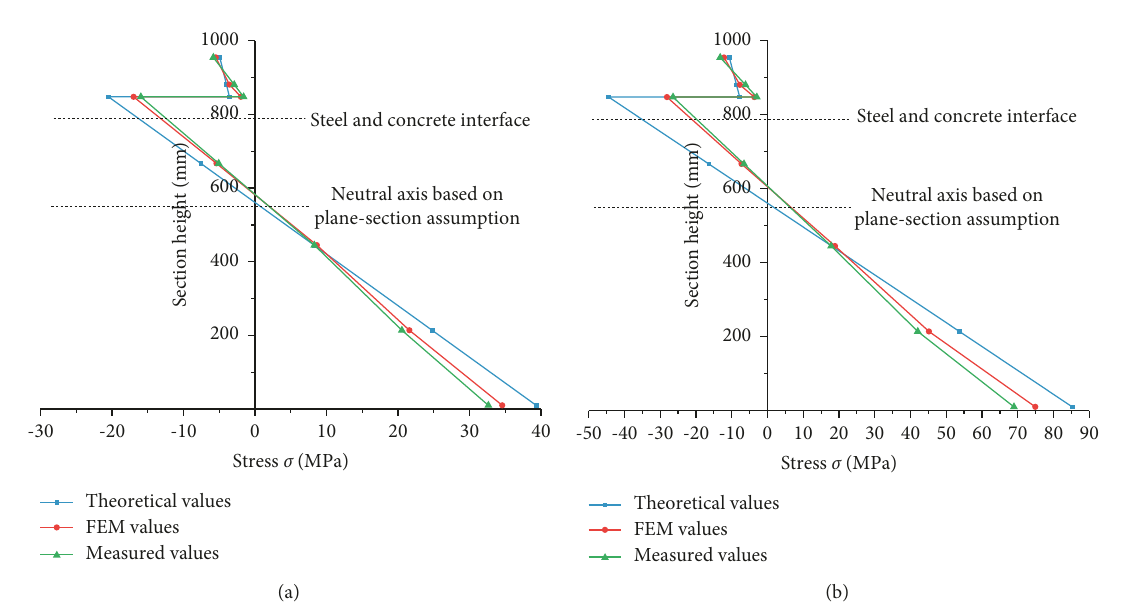
Figure 14: Comparison of the stress in the mid-span section of the composite track beam. The measured value was obtained by analyzing the measured data of the sensors. The FEM value was obtained by the finite element method. The theoretical value was obtained by the theoretical formulas of composite track beam with CDS in Section 2.2 when α � 0.9. (a) Load � 100kN. (b) Load � 200